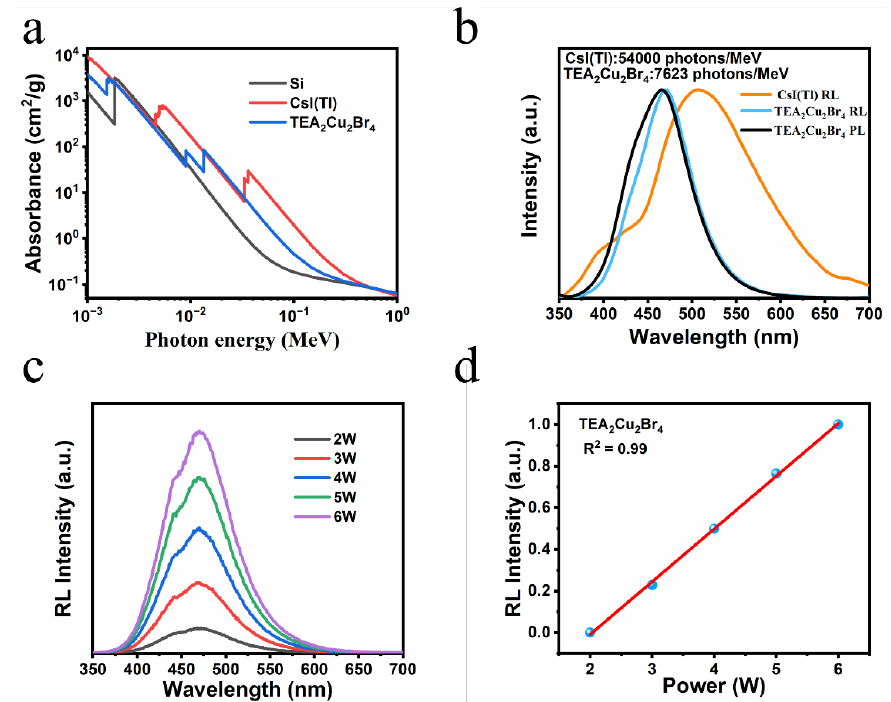
Figure 4. X-ray absorption and fluorescence spectra of TEA 2 Cu 2 Br 4 crystal. ( a ) Absorbance coeffi- cients of Si, CsI(Tl), and TEA 2 Cu 2 Br 4 . ( b ) TEA 2 Cu 2 Br 4 PL spectra, RL spectra, and CsI RL spectra. ( c ) TEA 2 Cu 2 Br 4 RL spectra with different X-ray excitation power. ( d ) The excitation power dependence of the RL intensity.